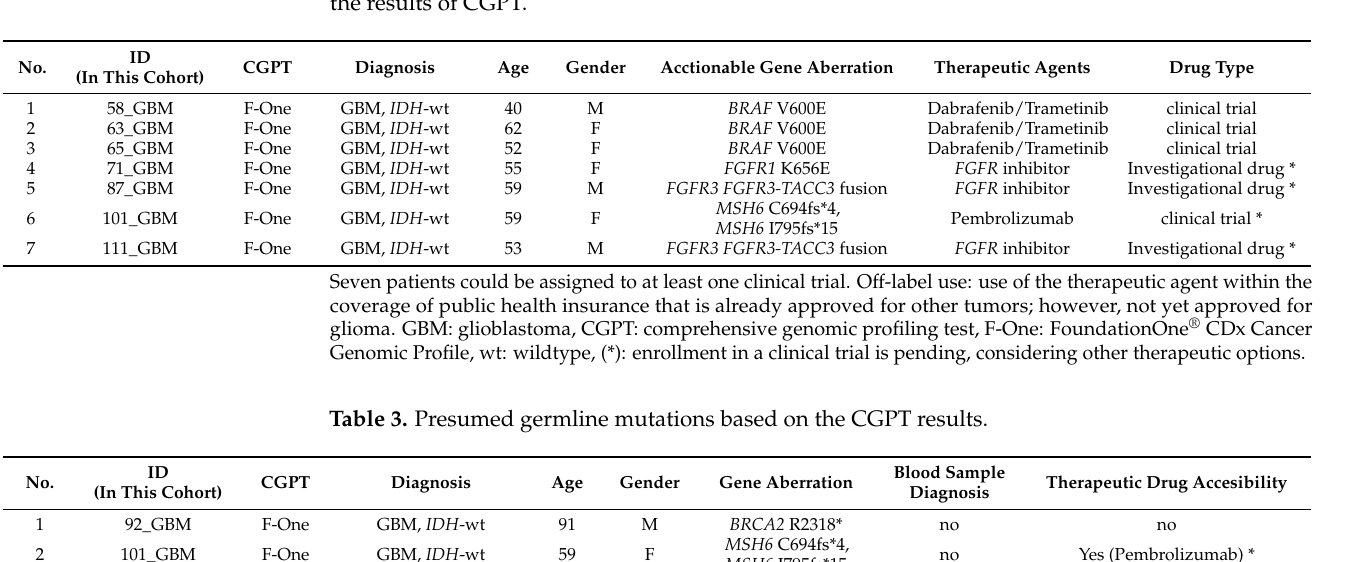
Table 2. Clinical actionability in the 31 IDH -wt GBMs of which the Molecular Tumor Board reviewed the results of CGPT.